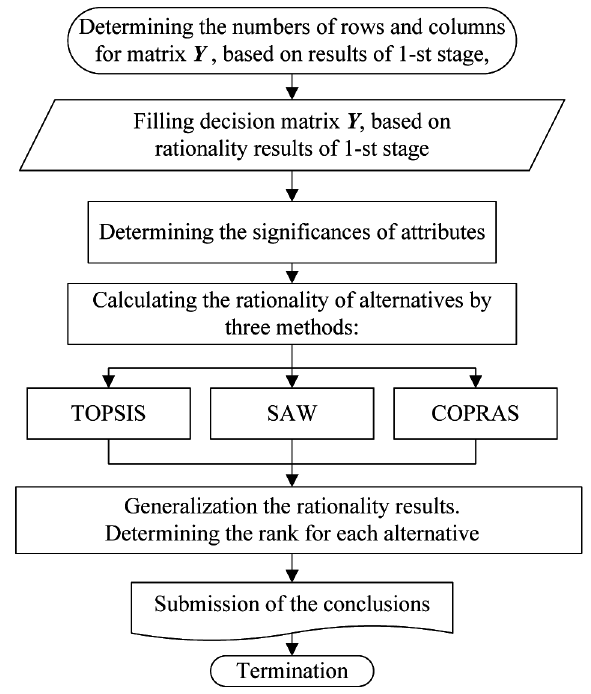
Fig. 2. Part 2 of the algorithm for the multi-stage decision synthesis method